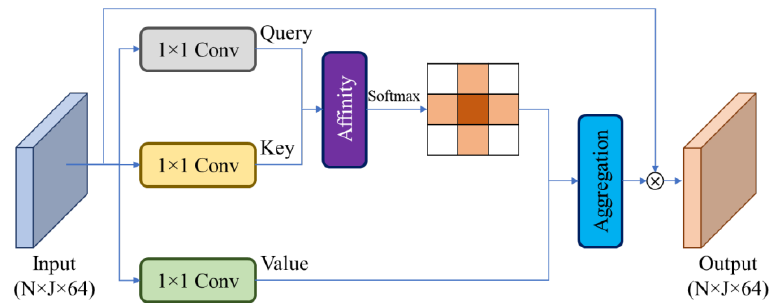
Figure 4. Criss-cross attention mechanism for the proposed HAR method.